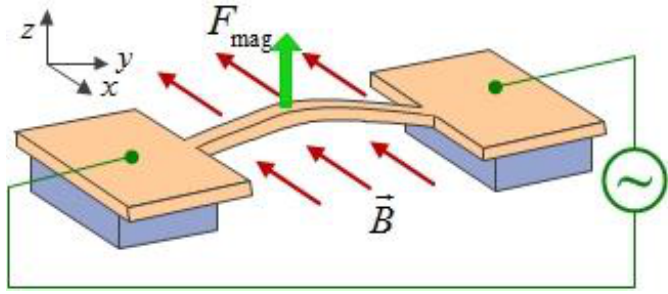
Figure 29. Schematic of magnetomotive actuation for the doubly clamped beam